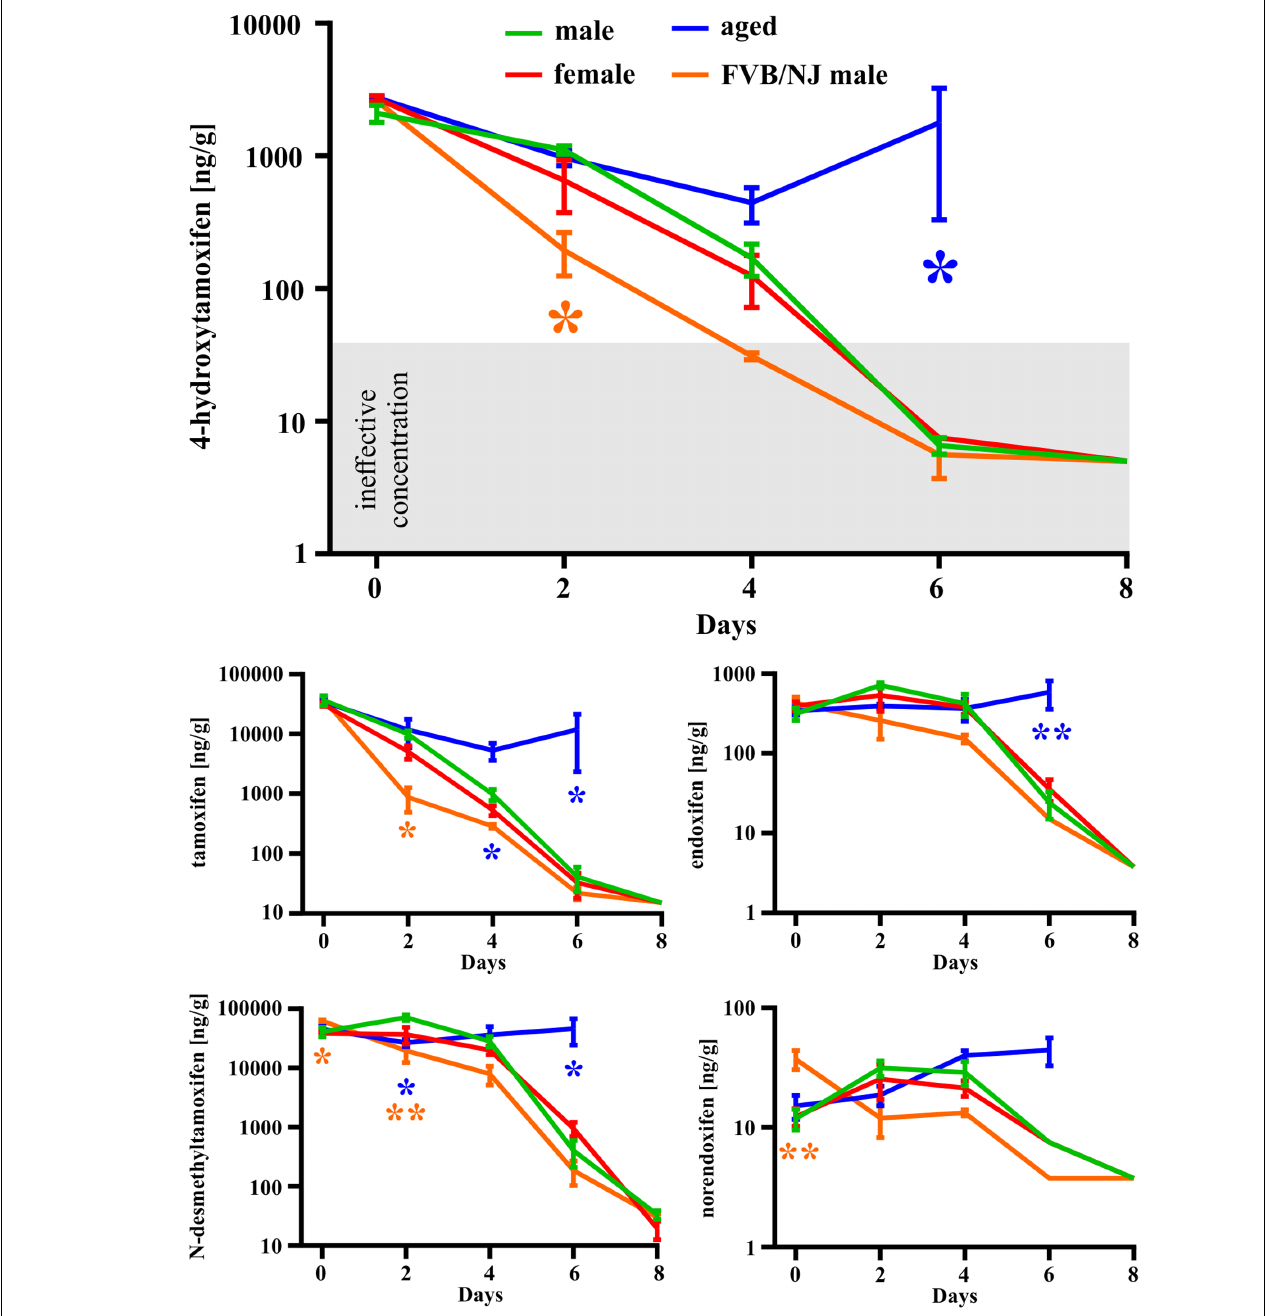
FIGURE 3 | Gender-, strain- and age-dependent differences in degradation of tamoxifen and its metabolites. Degradation of tamoxifen and its metabolites is significantly affected by age and strain of the mice. Significances are expressed above the x -axis by an asterisk in the color of the respective group relative to the male group (green line). Values of p < 0.05 were considered significant ( ∗ ), p < 0.01 very significant ( ∗∗